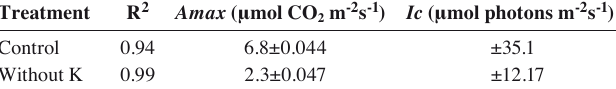
Fig. 1: Light saturation curves of photosynthesis in the tree tomato plants during vegetative growth (A vs. PPFD). Control (without K deficiency) (R 2 = 0.94); Plants grown without potassium K (potassium deficiency) (R 2 = 0.99). At the bottom of each figure the equation is derived from the fit to a Mitscherlich model. n = 3 plants per treatment. Tab. 2: Parameters obtained through the light response curve in the tree tomato plants during vegetative growth at 135 dat. Control (without K deficiency) and plants grown without K (potassium deficiency). These were calculated by fitting to a Mitscherlich model. A max = photosynthesis at saturation by light or maximum photosynthesis, Ic = light compensation point. n = 3 plants per treatment.